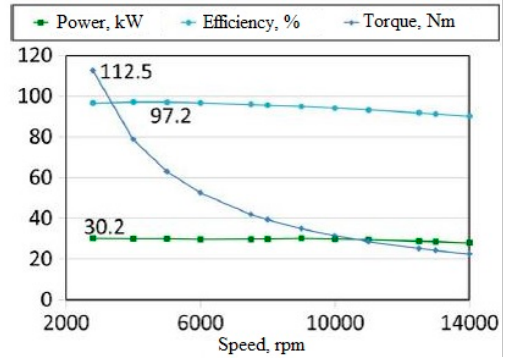
Figure 11. Electric motor efficiency, output power and torque under continuous power with speed [68].